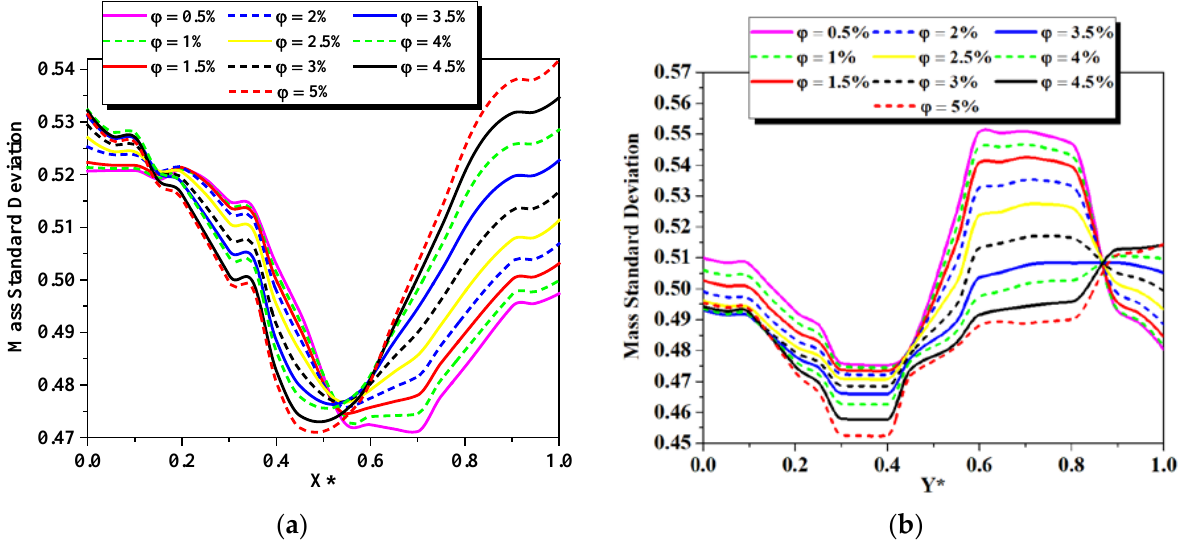
Figure 9. Evolution of the mass standard deviation along the ( a ): exit X-line and ( b ) exit Y-line of different cases of nano- fluid concentration (φ = 0.5 to 5%) at fixed Re g = 25.